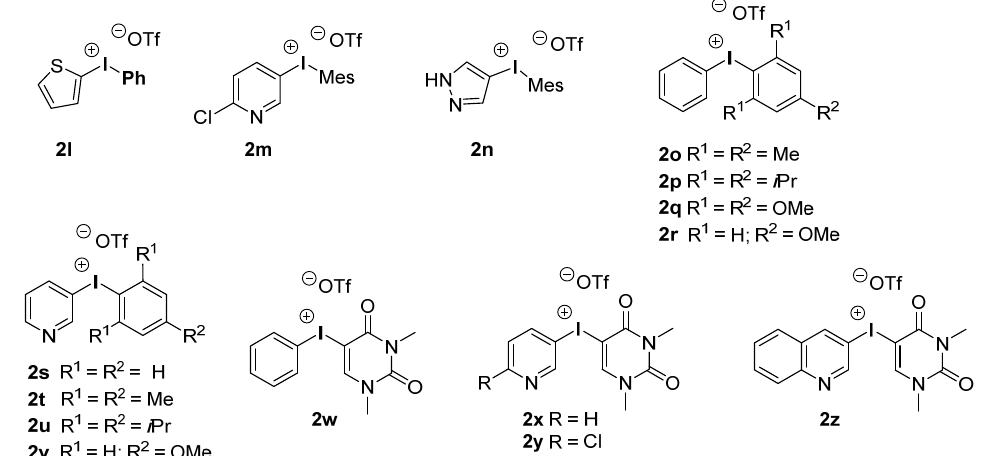
Figure 1. Unsymmetrical diaryliodonium triflates 2l–z that were used in this study. Table 3. Heteroarylation versus phenylation of 1 with unsymmetrical diaryliodonium salts 2l–n 1 .